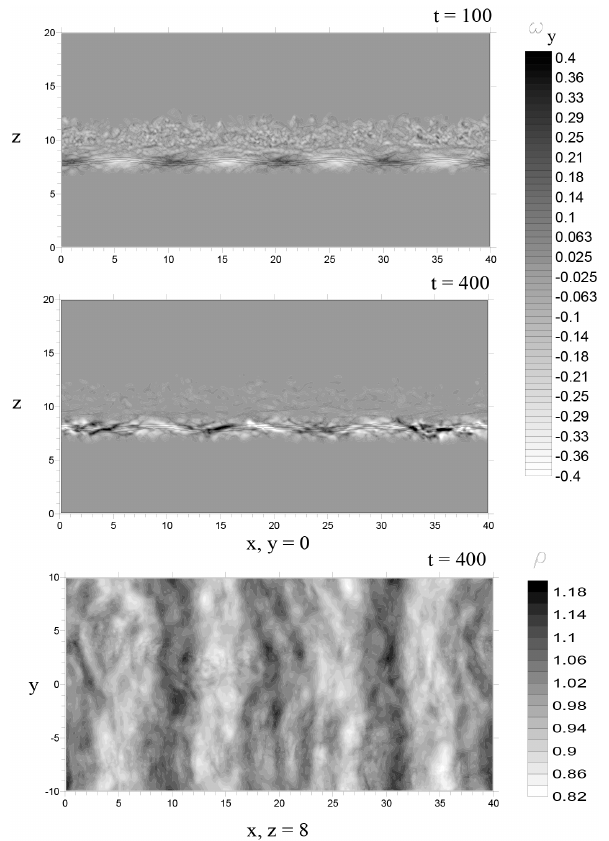
Figure 6. Instantaneous distribution of the vorticity y component ω y (in grey scale) with imposed density contours (1.3, 1.5, 1.7) in the central ( x , z ) plane at time moments t = 100 and t = 400 (top and middle panels, respectively), and density distribution in the ( x , y ) plane at the pycnocline level ( z = 8, bottom panel) at t = 400 obtained in DNS of the turbulence layer. IW wavelength λ = 10.